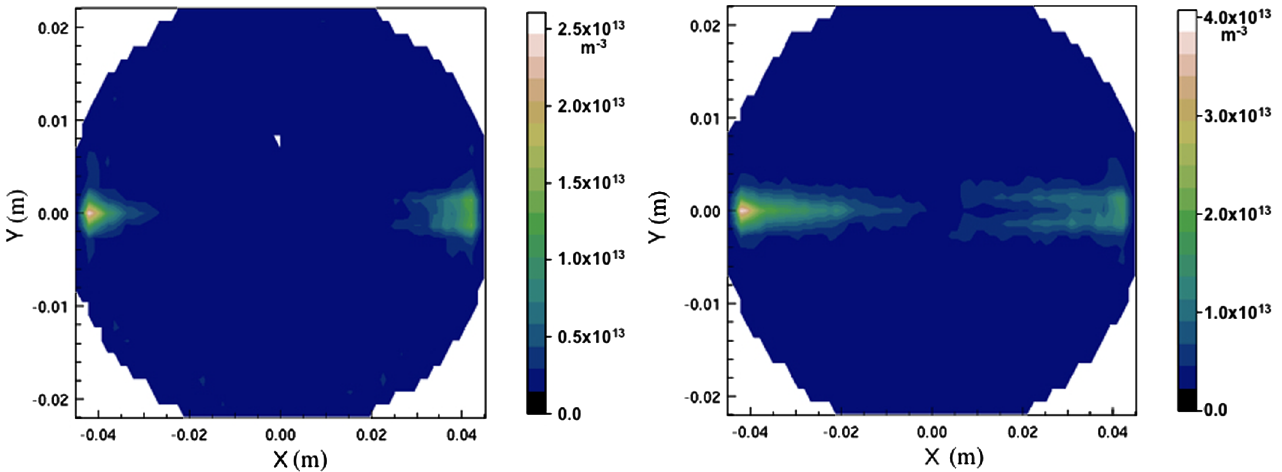
FIG. 4. Density in m (cid:1) 3 in the x - y plane for all electrons with z within 3.134 mm of the z at which B y ¼ 0 . Snapshots in time just before the arrival of bunches 11 (on left) and 45 (on